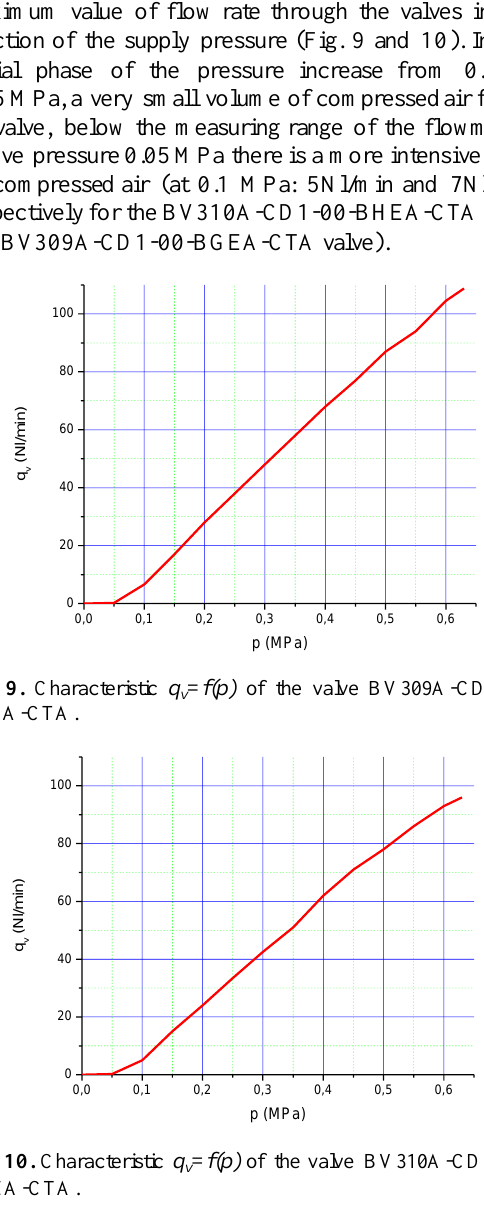
=f(p) of the valve BV310A-CD1-00- v